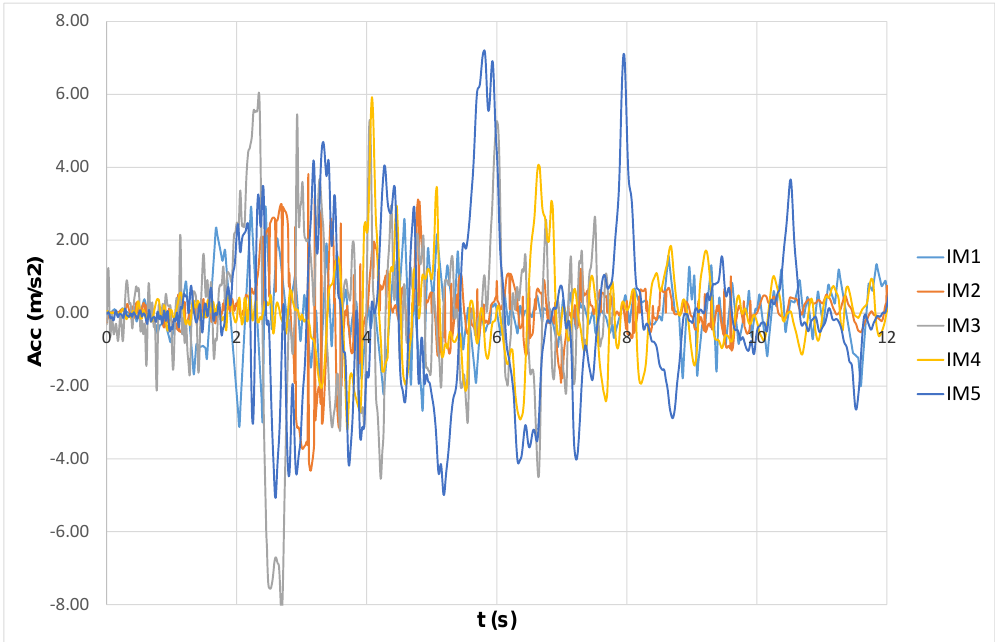
Figure 5. Acceleration time histories at the bedrock.